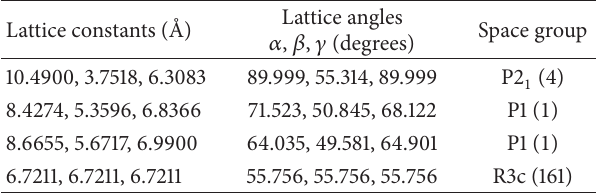
Table 2: Evolution of ZnSnS 3 cell structure transition